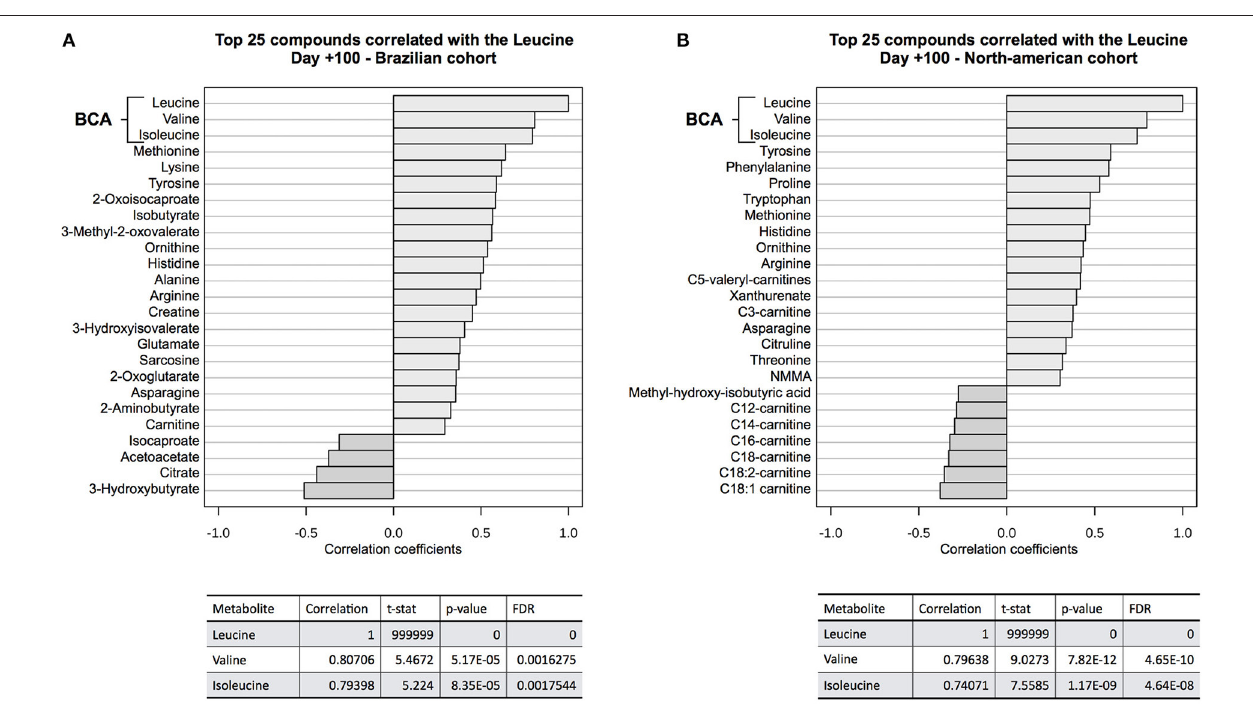
FIGURE 5 | Correlation analysis to leucine at day + 100. BCAA blood concentrations were well correlated to leucine concentration at (A) discovery cohort and (B) validation cohort. Other correlated metabolites in both cohorts were tyrosine, histidine, arginine, ornithine, methionine, and asparagine, showing evidence of overall consistence of metabolic profile measurements in both cohorts. 2-oxo-isocaproate and 3-methyl-2oxovalerate, BCAA degradation products, were also well-correlated in the discovery cohort. These BCAA degradation products were not detected by LC-MS/MS platform on validation